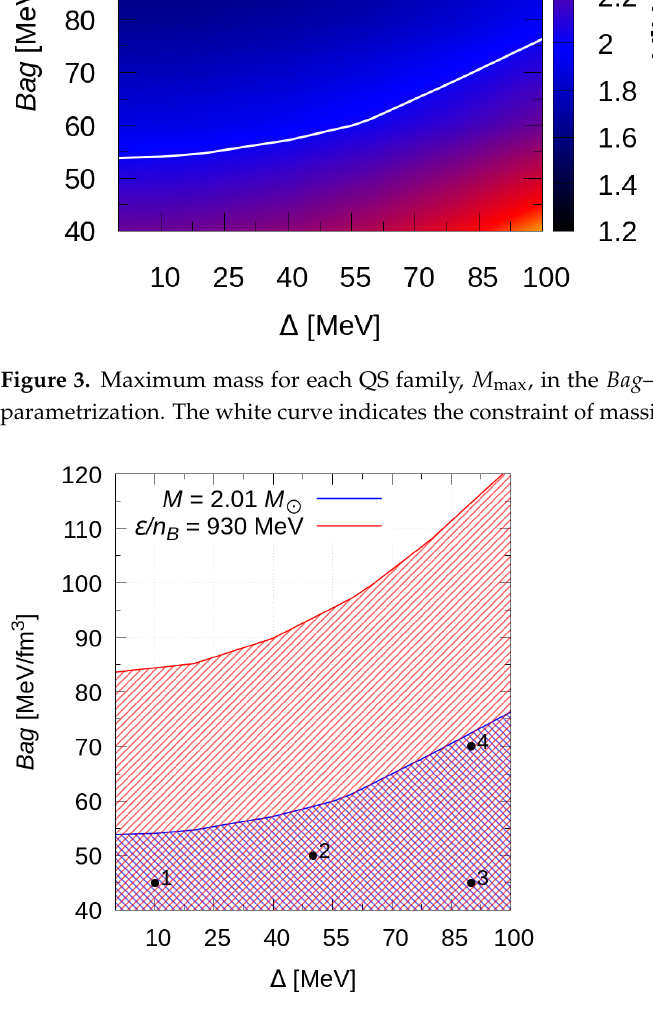
Figure 4. Bag – ∆ plane showing the stability window and the M max ≥ 2.01 M (cid:12) allowed regions. We selected four qualitatively representative sets (Table 2) of the general behavior of our model from the overlapping region where both conditions are